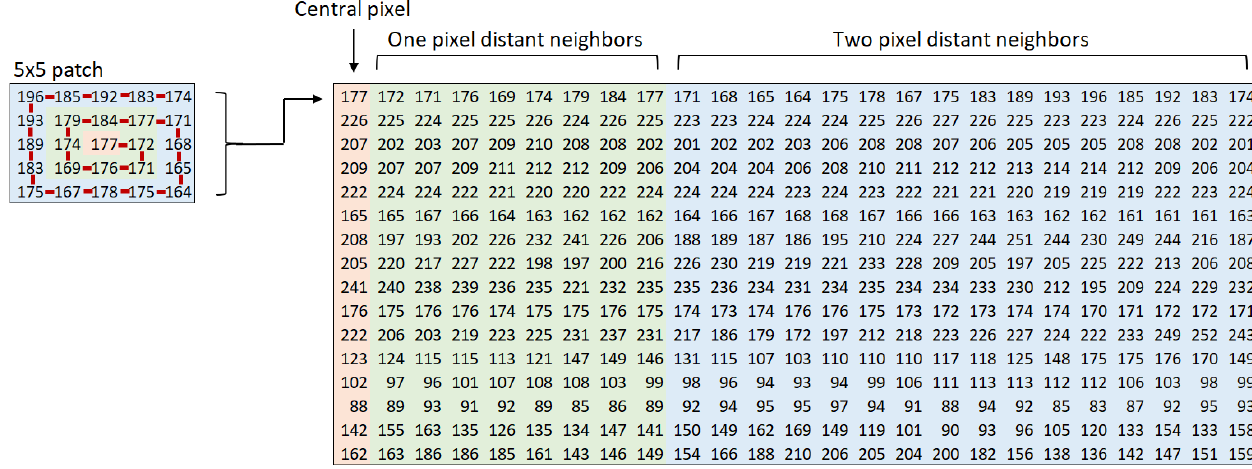
Figure 8. Representation of 16 patches with 25 intensity values per patch. The spiralout option of the PatchIndexing parameter starts from the innermost pixel and gradually extends to the outer pixels of the patch in a clockwise direction. The patch pixels are indexed in squares of increasing distance from patch